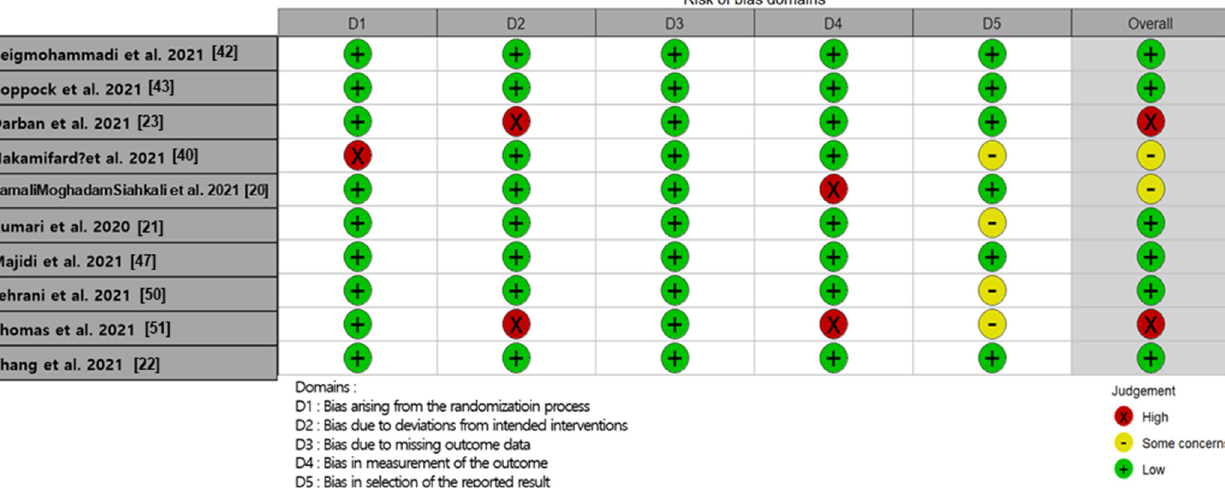
Figure 2. Traffic light plot of risk of bias assessment of included studies using RoB 2.0 criteria, and overall risk of bias. Table 2. Quality assessment by the Newcastle-Ottawa quality assessment scale.